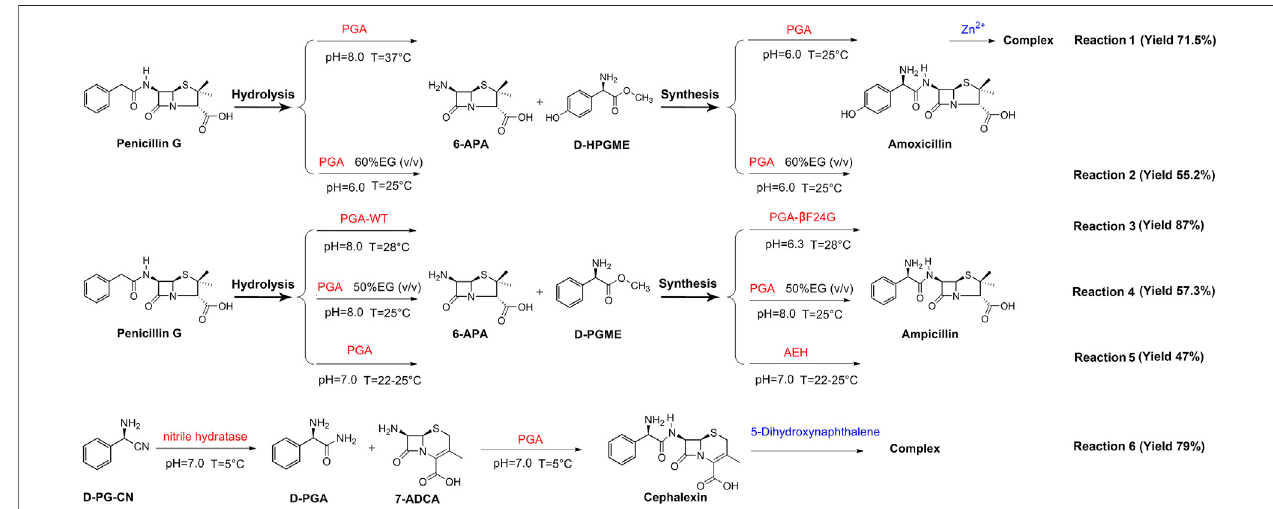
FIGURE 5 | Application of one-pot reaction cascade in the synthesis of β -lactam antibiotics by